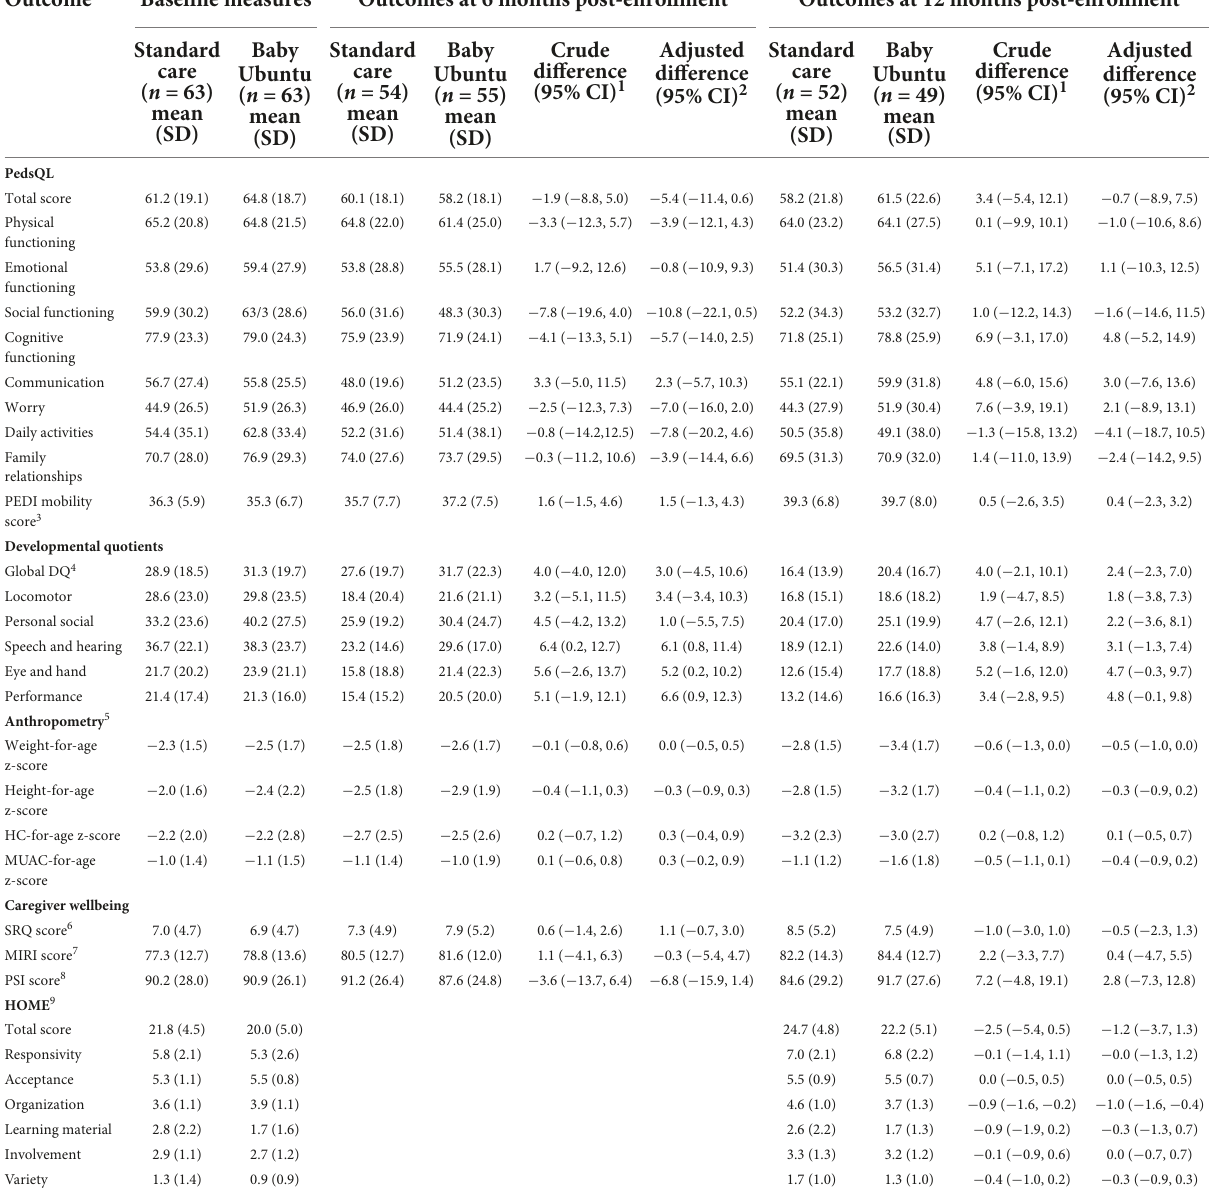
TABLE 2 Outcomes at baseline, 6 and 12 months post-enrollment to the baby Ubuntu program, by arm. Outcome Baseline